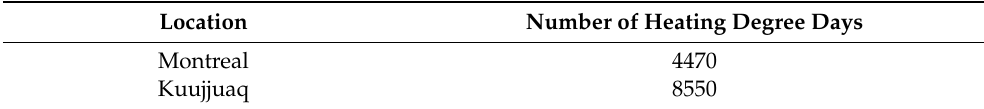
Table 2. The number of heating degree days (base temperature: 18 ◦ C) at the two different locations that were considered in this work, which ranges from cold to subarctic